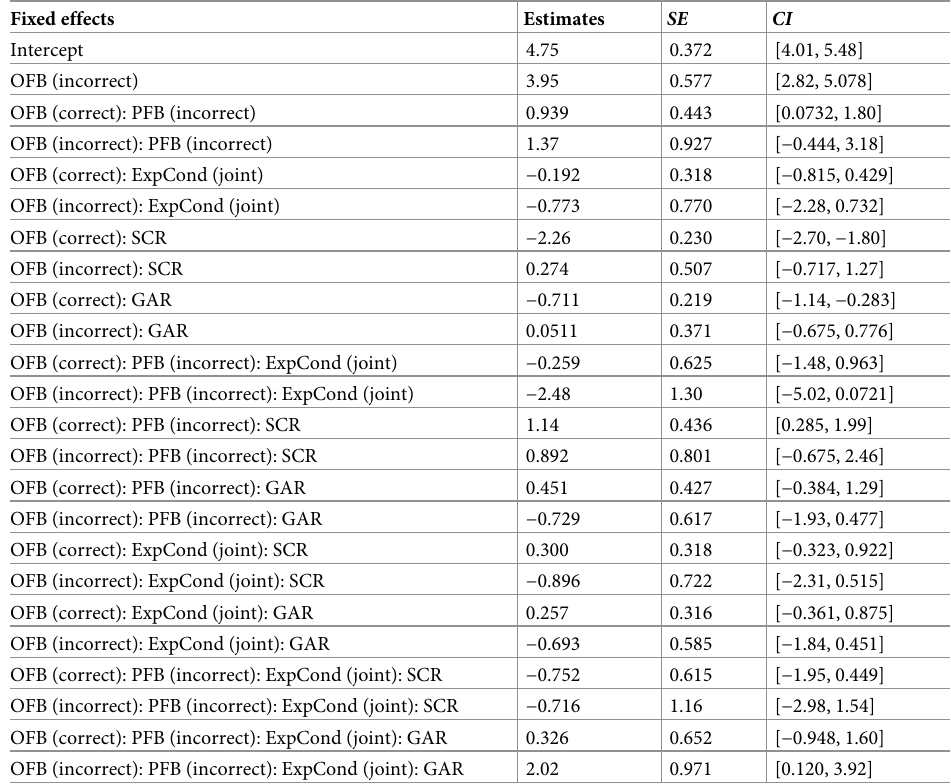
Table 5. Estimated coefficients of fixed effects in LME for gain- and loss-related P300.